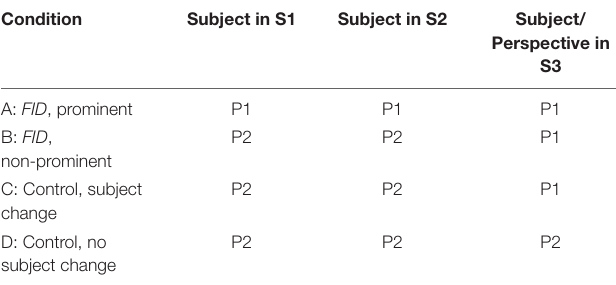
TABLE 2 | Overview of experimental conditions; “P” stands for